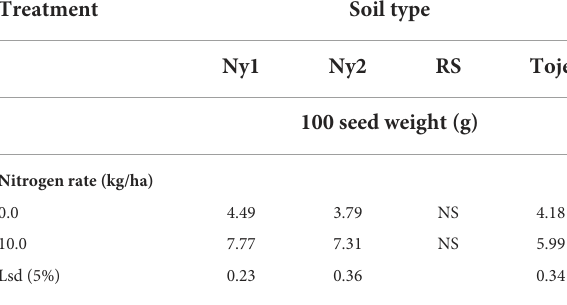
TABLE 7 Effect of varying rates of N on seed weight * .